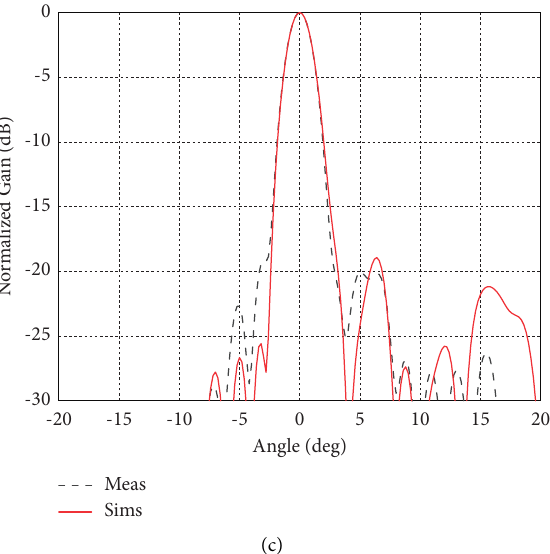
Figure 9: Radiation pattern at 14GHz and γ � 0 ° . (a) Far-field pattern. (b) Elevation plane. (c) Azimuth